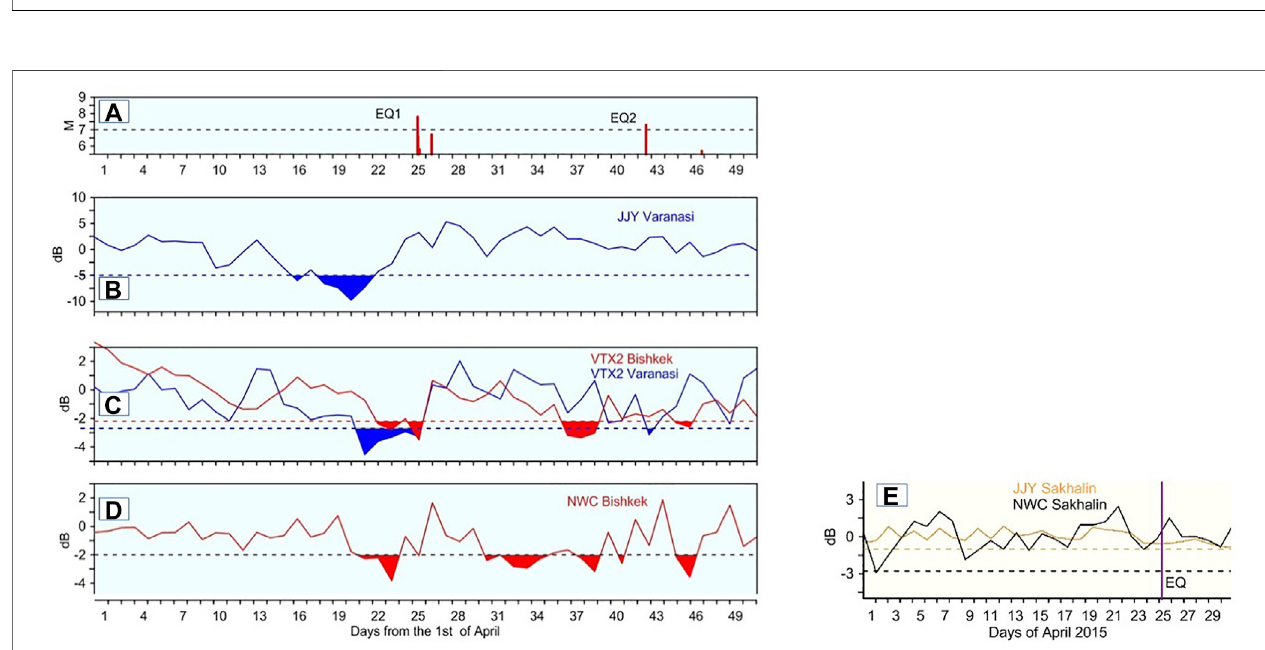
FIGURE 11 | The VLF/LF network. Green circles show the positions of receiving stations. Red triangles show transmitters. The lines are propagations paths from the transmitters to receivers. Brown circles show the epicenters of earthquakes with M > 5.5 for the period 2013-2015. Bl A map of the wave paths under analysis together with the epicenters of earthquakes with M > 7 (solid brown circles) occurred in April-May 2015. KGZ stands for the station in Bishkek (Kirgizstan), VAR means the station in Varanasi (India), YSH is the station in Yuzhno-Sakhalinsk (Sakhalin Island). The areas of earthquake preparation where precursors can be found are shownbytheyellowcircleforthe fi rstlargerearthquakeonApril25andthepinkcircleforthesecondearthquakeonMay12,2015.Theellipsesareprojectionsofthethird Fresnel sensitivity zone on the Earth ’ s surface.